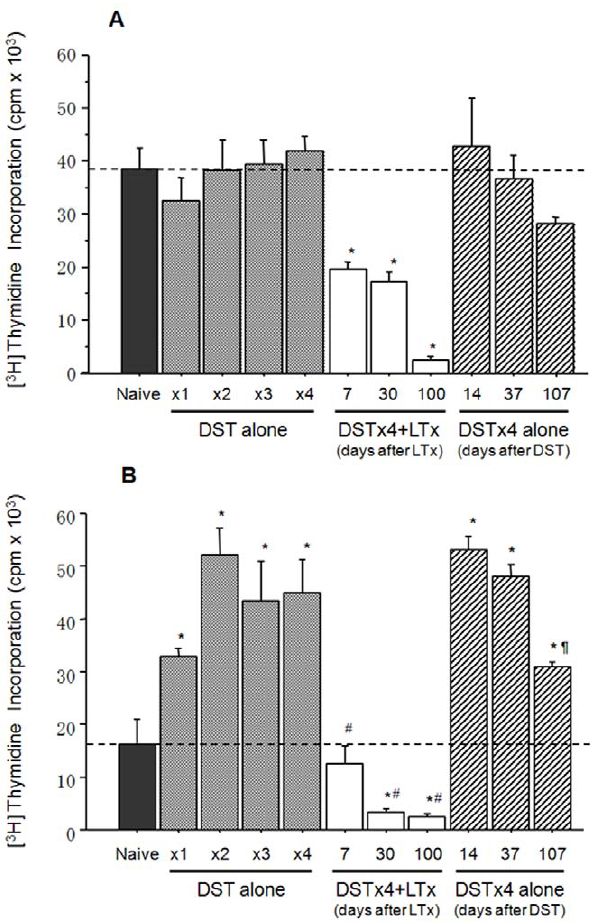
Figure 2. Alloreactive responses of T-cells obtained from LEW rats subjected to DST alone or DSTx4 + LTx invitro . (A) T-cells (1 6 10 5 ) from LEW rats subjected to one or more weekly DST treatments with or without LTx were incubated with irradiated DA splenocytes (2 6 10 5 ) for 5 days to induce T-cell proliferation. The dotted line shows the proliferation of T-cells from naı¨ve LEW rats. DSTx4 alone at 14, 37 and 107 days represent alloreactive responses of T-cells obtained from LEW rats pretreated with 4 weekly DST treatments and then harvested at 14, 37 and 107 days following the last DST treatment (no LTx). *P , 0.05 compared with proliferation of T-cells from Naı¨ve LEW rat. (B) CD4 + T-cells (1 6 10 5 ) from LEW rats subjected to one or more weekly DST treatments with or without LTx were incubated with irradiated DA splenocytes as described above. The dotted line shows the proliferation of CD4 + T-cells from naı¨ve LEW rats. *P , 0.05 compared with Naı¨ve LEW rat. # P , 0.05 compared with DSTx4. " P , 0.05 compared with DSTx4 alone at 14 d. Data represent mean 6 SD from at least three independent experiments.